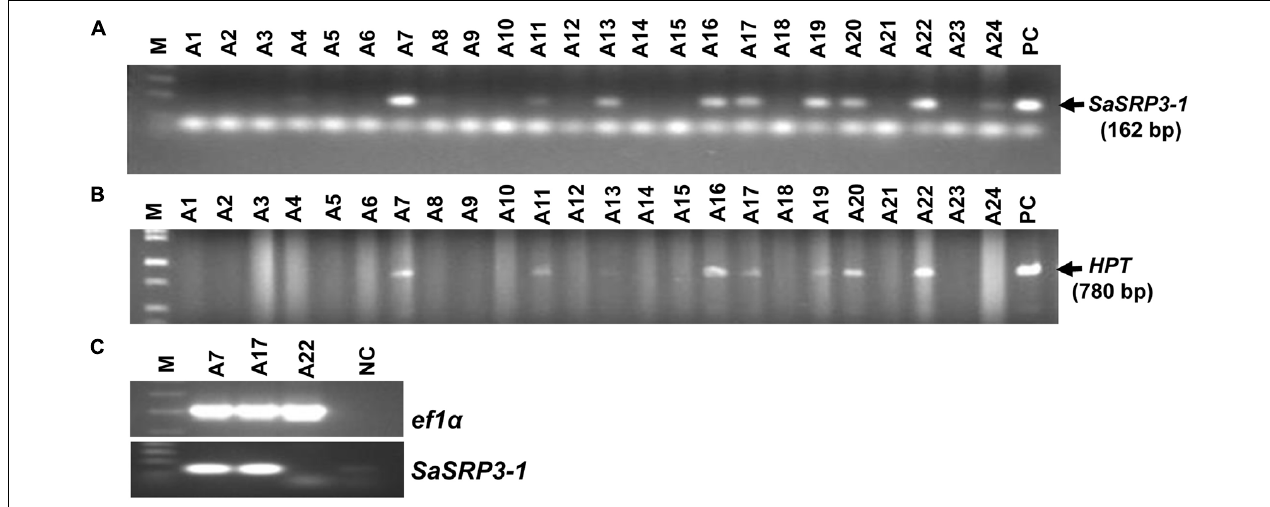
FIGURE 3 | Confirmation of SaSRP3- 1 containing T 0 transgenic rice plants by PCR and detection of SaSRP3-1 mRNA by semi-quantitative RT-PCR analysis of transgenic seedlings grown in greenhouse condition. (A) PCR confirmation using SaSRP3-1 specific primers; (B) PCR confirmation of T 0 plants using hygromycin phosphotransferase ( hptII ) specific primers. M: 1 Kb DNA ladder, A1 to A24: DNA isolated from individual T 0 transgenic plants, PC: Positive control; (C) a representative RT-PCR experiment for detection of expression of elongation factor 1- α ( ef1 α ) and SaSRP3-1 mRNA in seedling stage leaf samples of transgenic and Cocodrie (WT) plants. M: 1 Kb ladder, A7, A17, and A22: transgenic plants with SaSRP3-1 gene, NC: Negative control without any